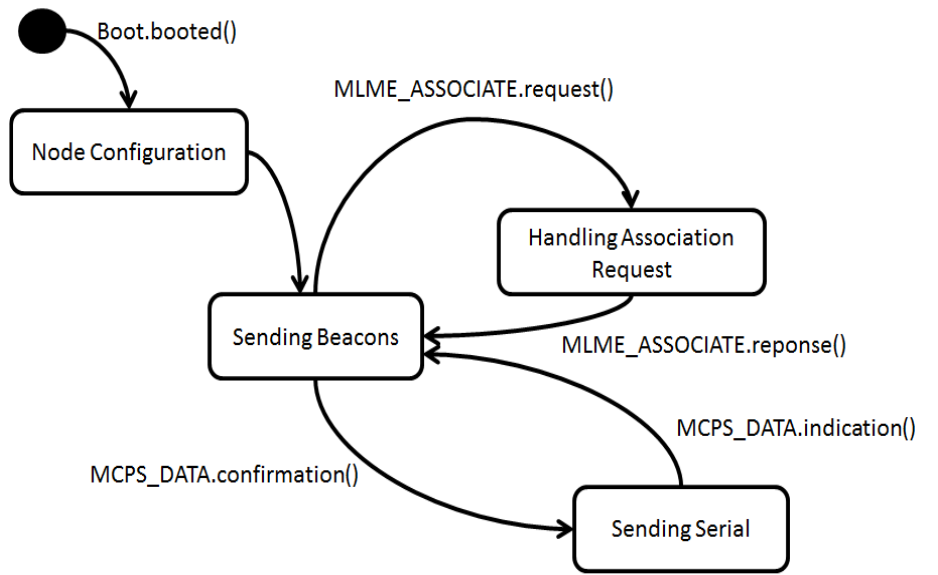
Figure 12. Main Node State